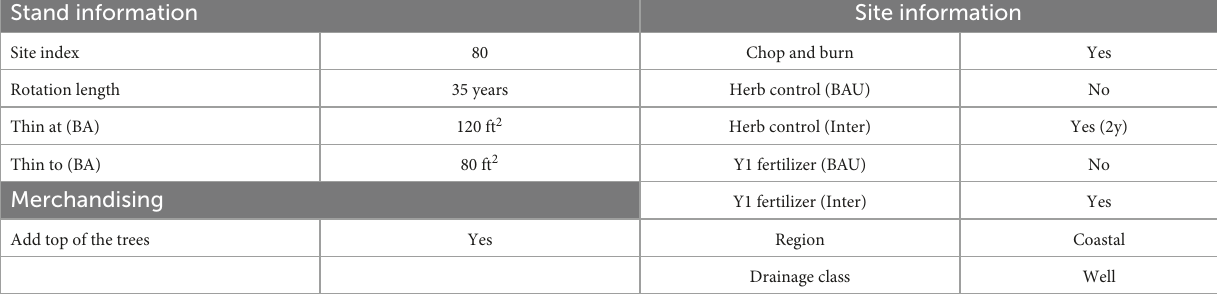
TABLE 2 Stand and site parameter inputs for pine plantation simulations in PTAEDA4.0.